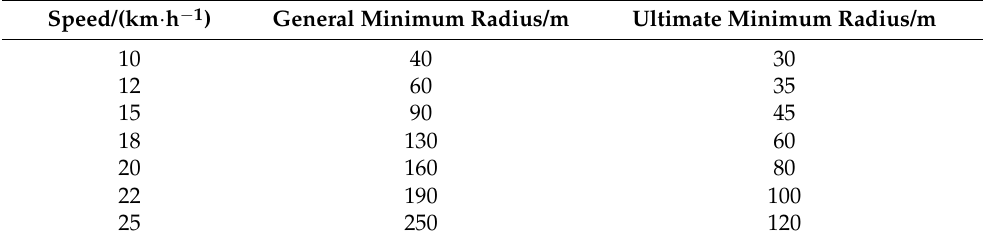
Table 1. Recommended minimum radius of a horizontal curve